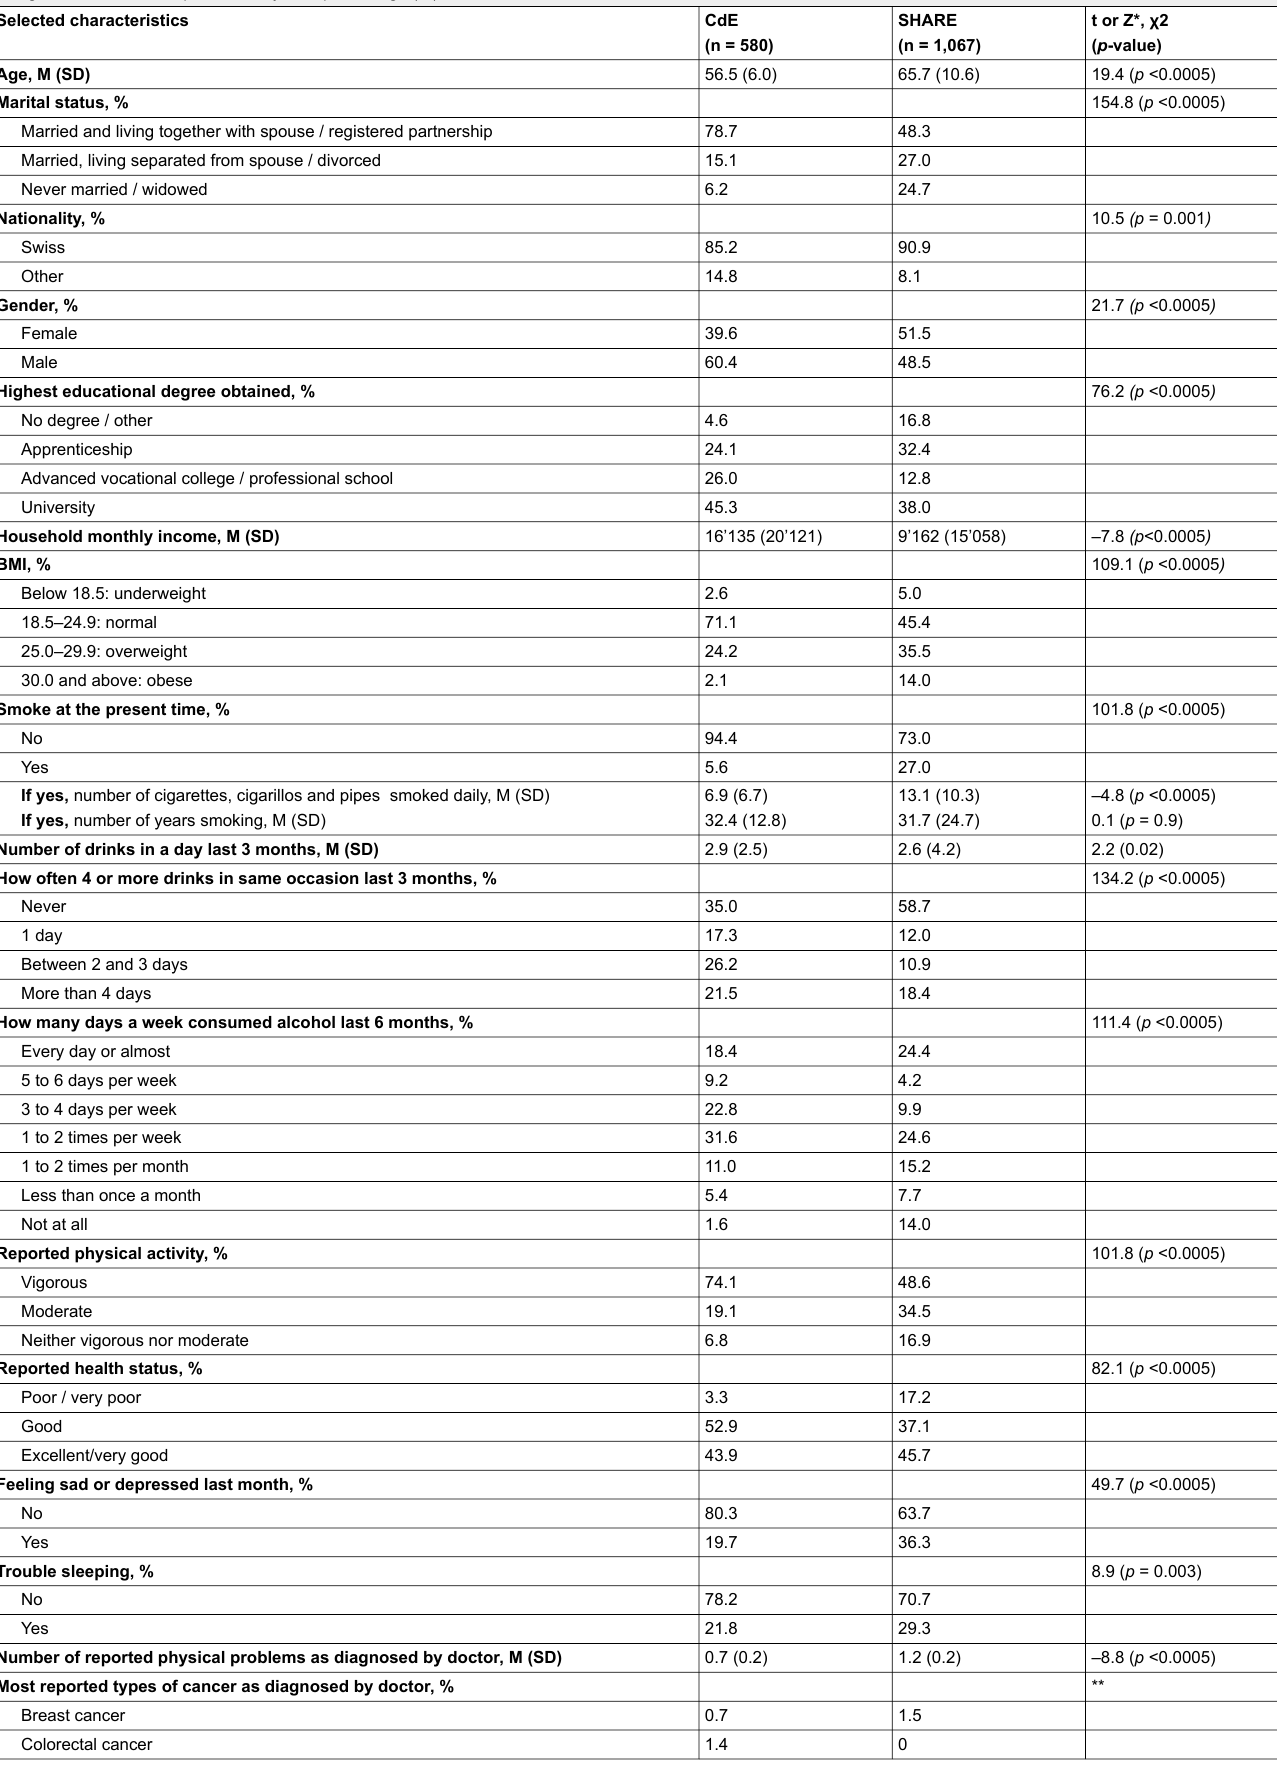
Table 1: Comparison of CdE and SHARE groups for some unadjusted measures. Interval variables are presented by their mean and standard deviation (SD), whereas categorical variables are presented by their percentage (%). Selected